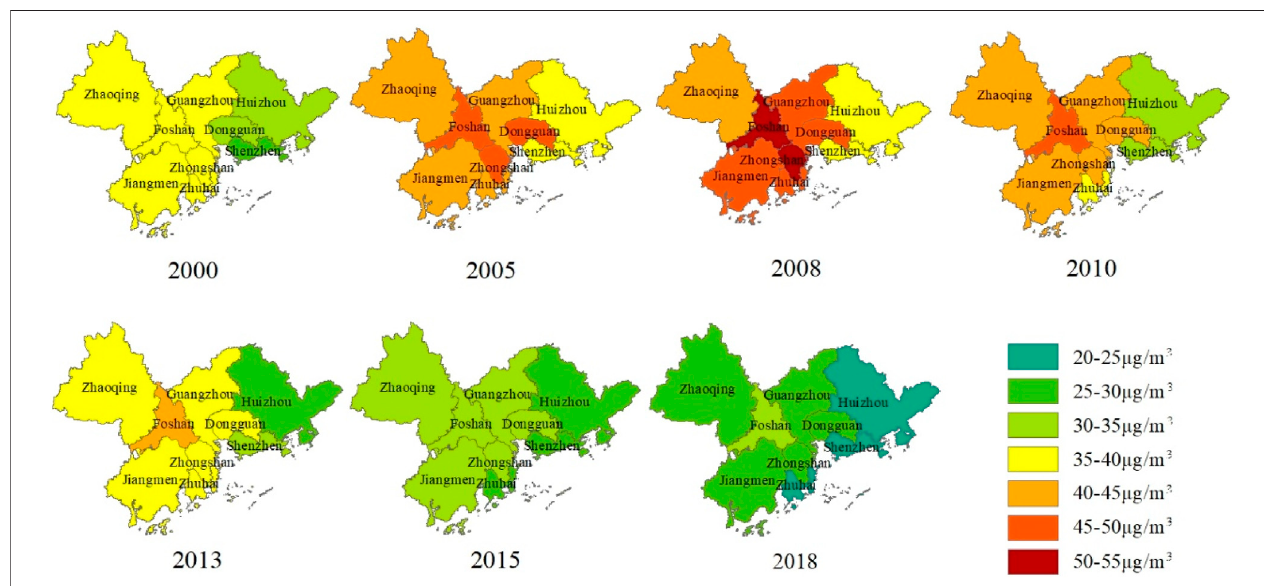
FIGURE 3 | PM 2.5 concentration distribution in the Pearl River Delta region from 2000 to